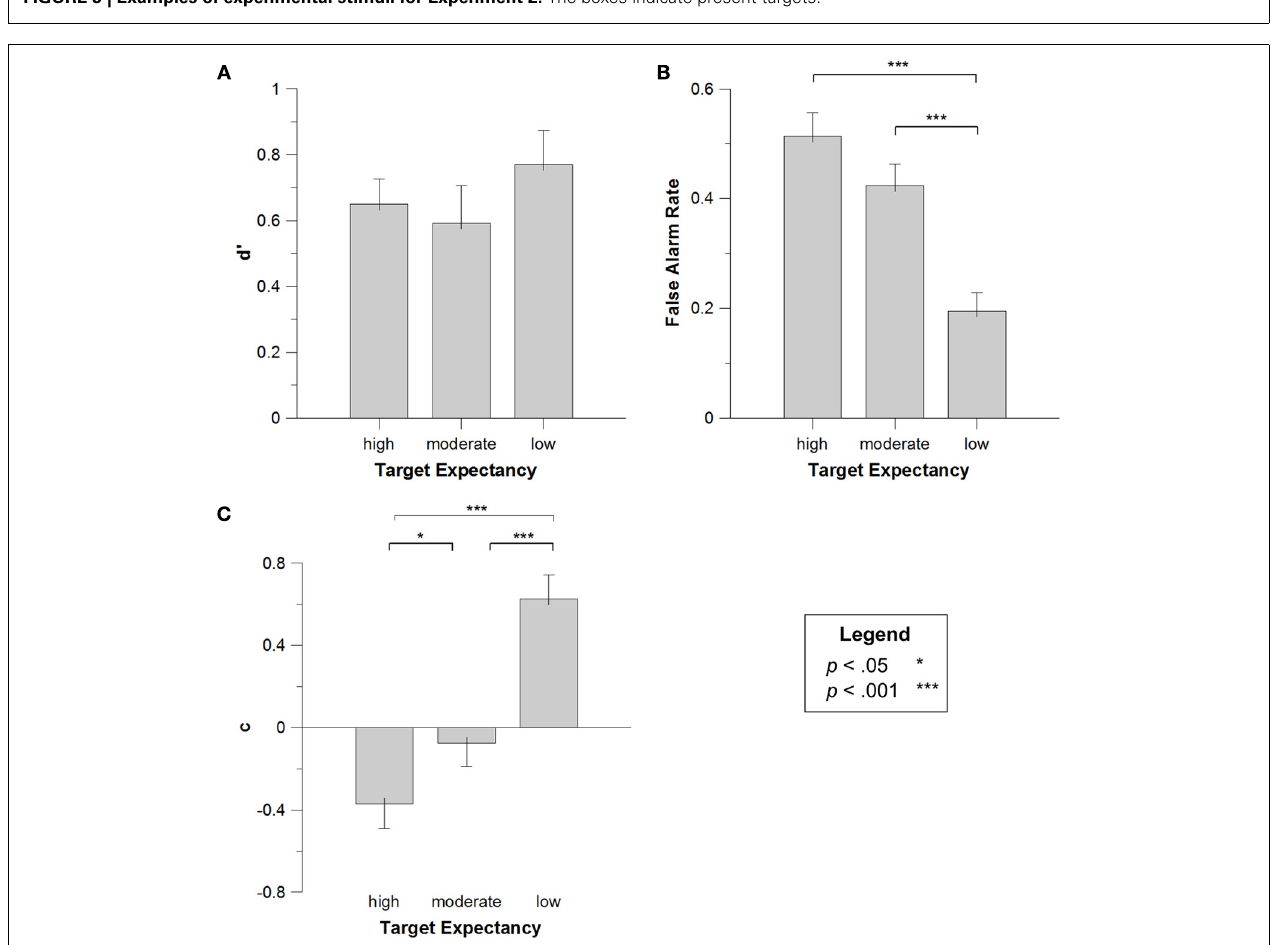
FIGURE 4 | d (cid:2) (A), false alarm rate (B) and c (C) for high, moderate, and low expectancy targets in Experiment 2. Error bars depict the standard error of the mean.